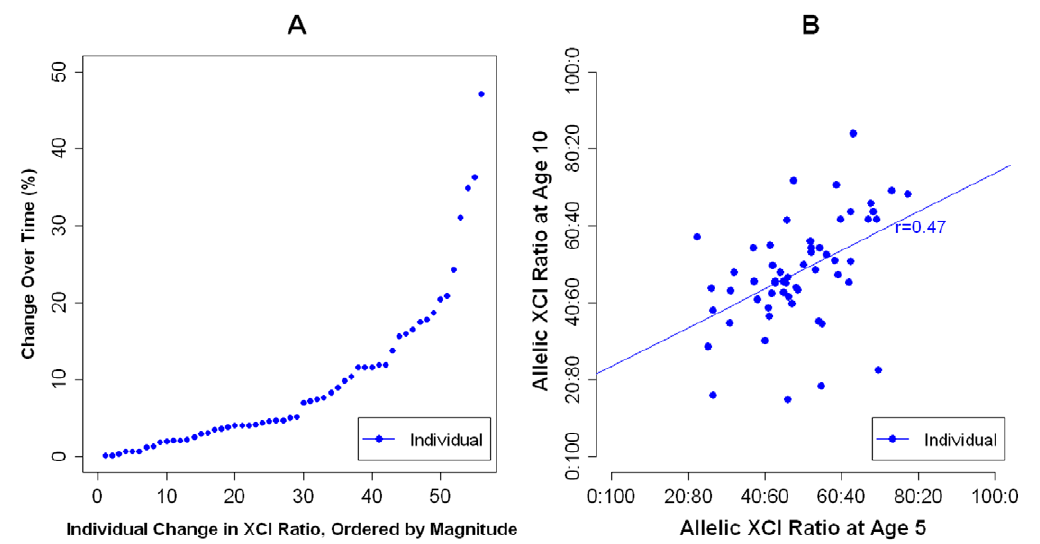
Figure 2. Longitudinal analysis of allelic XCI ratios in female children over early childhood development. ( A ) Individual changes in absolute XCI ratio between ages 5 and 10 years. ( B ) Inter-individual stability correlation for XCI ratio, between ages 5 and 10 years. XCI=X- Chromosome Inactivation .